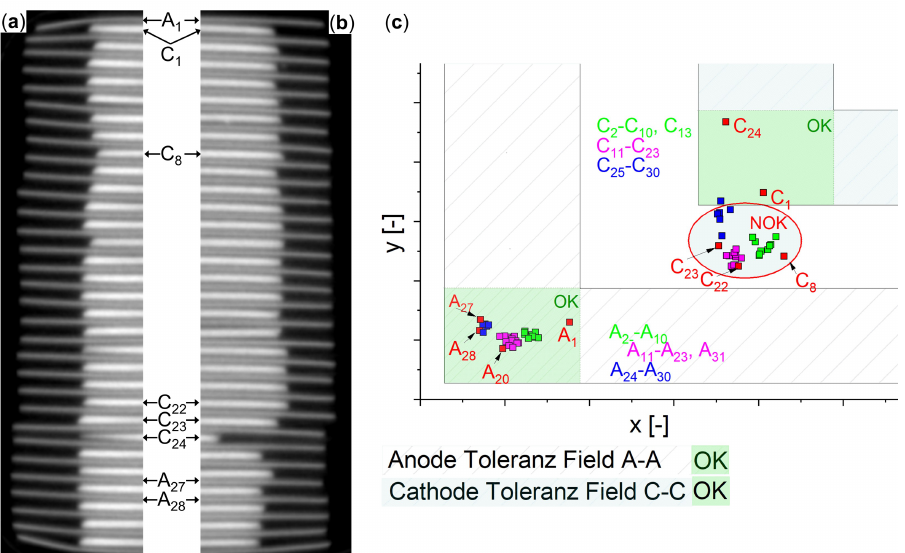
Figure 4. ( a ): CT slice in x 0 z 0 -plane. ( b ): CT slice in y 0 z 0 -plane. ( c ): The diagram shows the calculated electrode edge points of the investigated ESC corner. Moreover the relative tolerance field of anodes and cathodes are